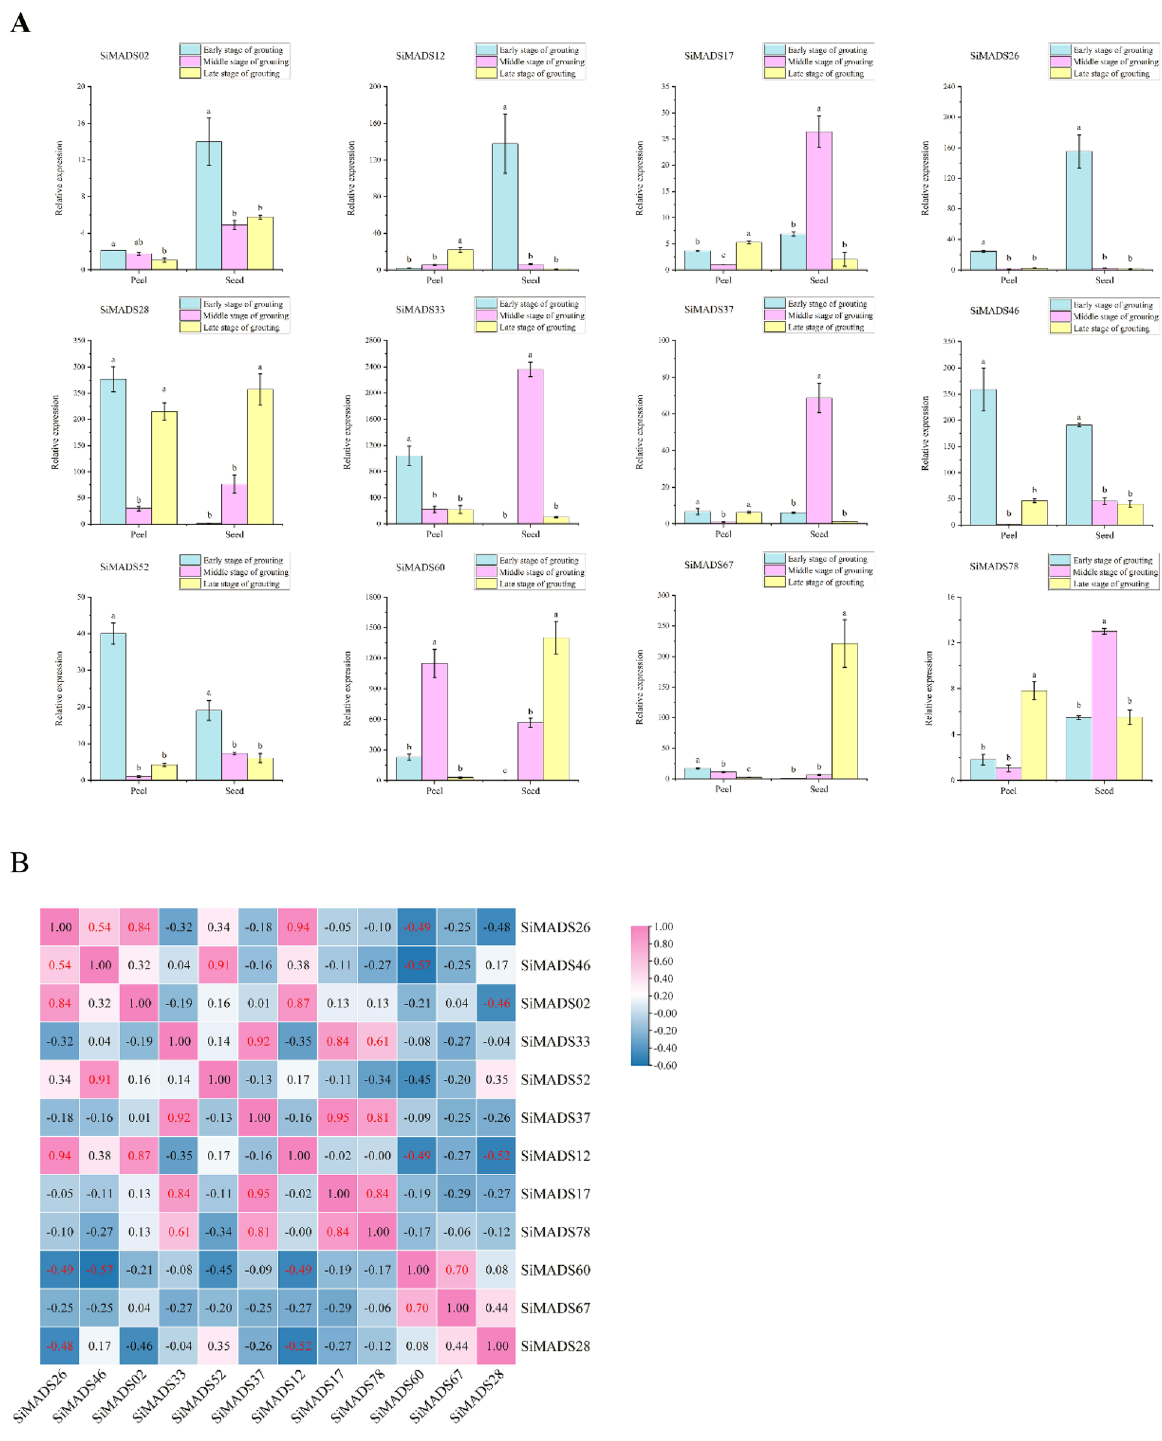
Figure 8. Expression pattern and correlation of 12 S. italica MADS-box genes during fruit development. ( A ) qRT-PCR was used to detect the expression patterns of 12 S. italica MADS-box genes in peel and fruit before, during and after grain filling. Error bars were obtained from three measurements. Lowercase letter above the bar indicates significant difference (α = 0.05, LSD) among treatments. ( B ) Positive number: positively correlated; negative number: negatively correlated. Red numbers indicate a significant correlation at the 0.05